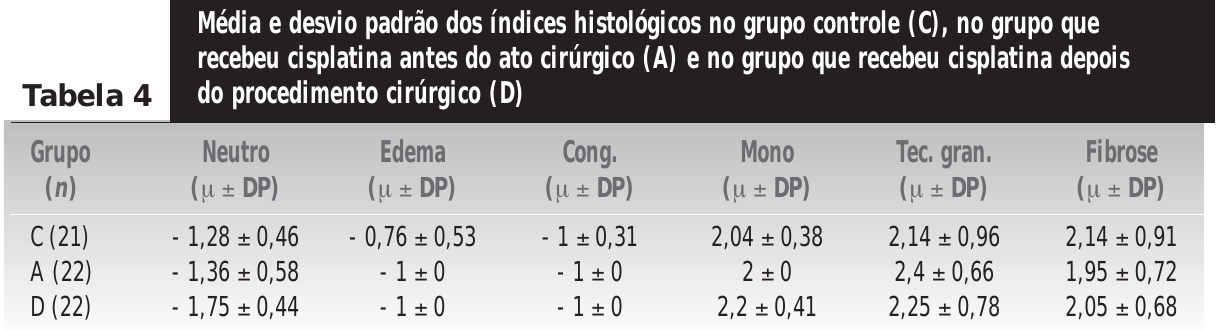
2,2 no grupo que recebeu cisplatina depois do procedi- mento cirúrgico (D). O tecido de granulação apresentou índices médios de 2,14; 2,25 e 2,4 nos grupos C, D e A, respectivamente. A intensidade da fibrose apresentou ín- dices médios de 1,95; 2,05 e 2,14 para os grupos A, D e C, respectivamente. Não houve diferença significativa entre os grupos que receberam cisplatina e o grupo controle para estes três últimos achados histológicos. grupos C5, A5 e D5 apresentaram processo inflamatório subagudo, pois suas médias finais foram 2,72; 1,72 e 2, respectivamente. Já os grupos C8, A8 e D8 foram classifi- cados como portadores de processo inflamatório crônico, pois suas médias finais foram de 3,9; 4,27 e 3,5, respecti- vamente ( Tabela 5 ).